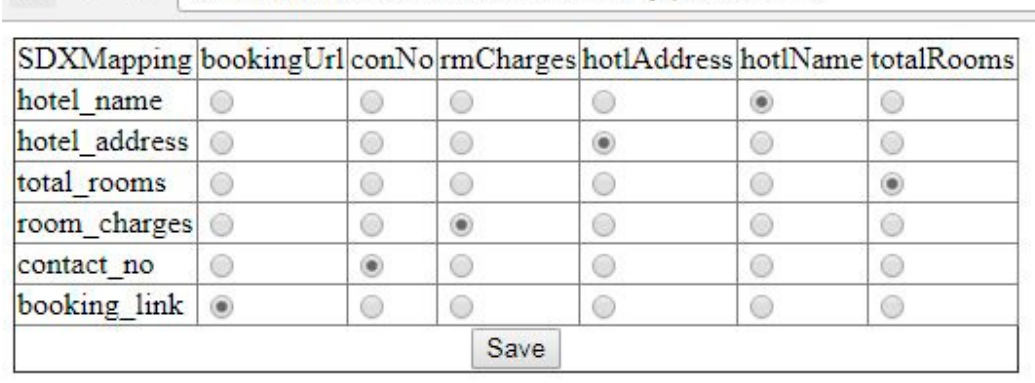
Table 8. End to End SDXMapping between EU#01 and (MSP#01 and DSP#03). EU#01 (www.user1.com)